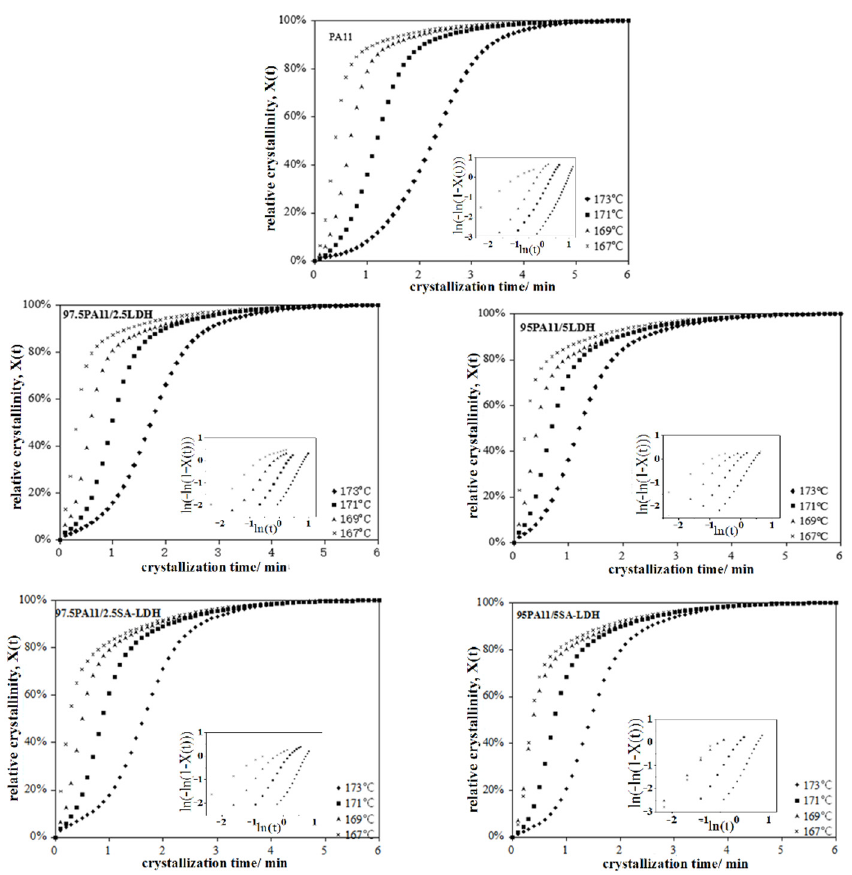
Figure 7. Relationship between the relative crystallinity and crystallization time of PA11 and its composites. Table 5. Some parameters from the Avrami equation for PA11 and its